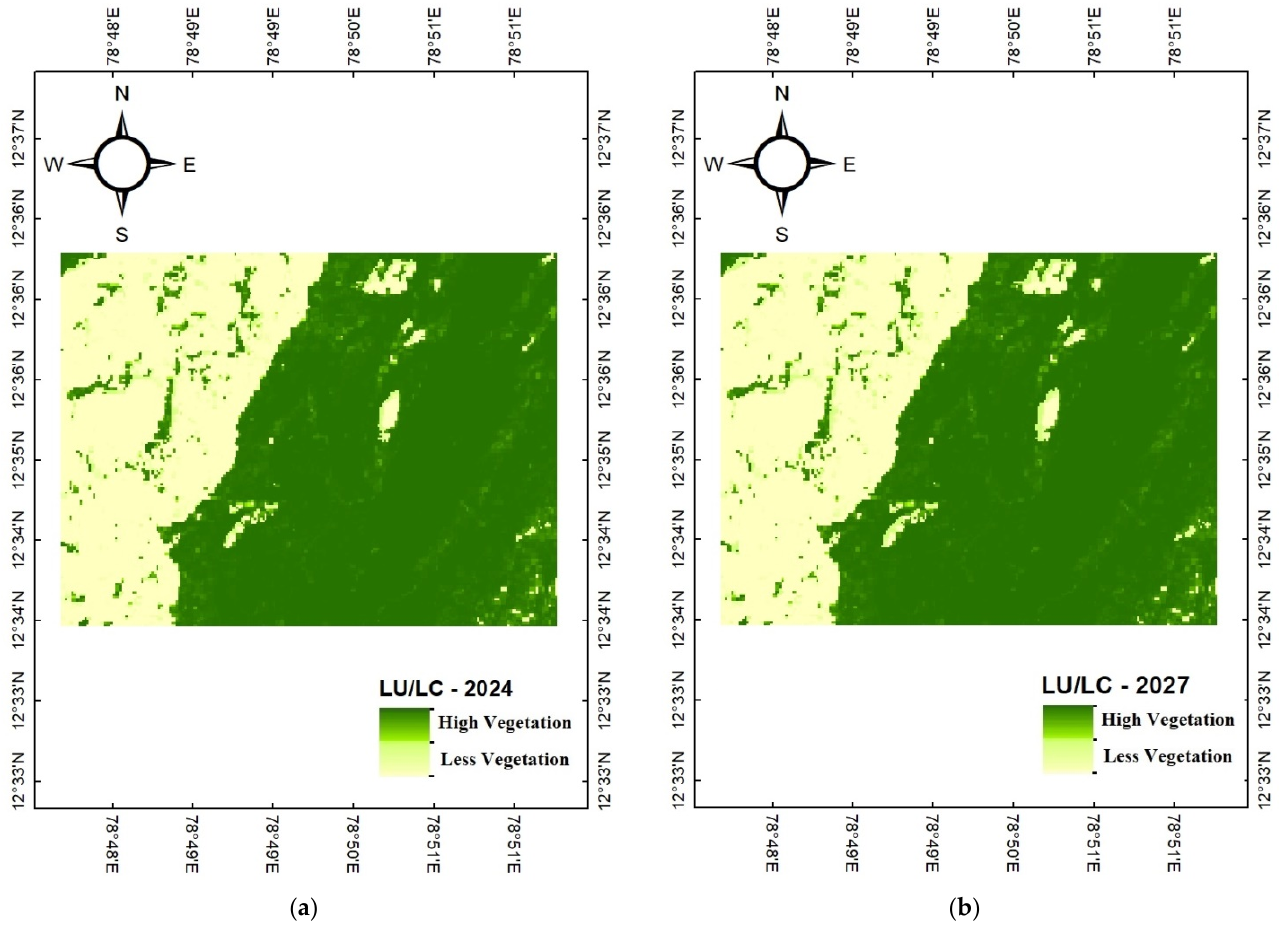
Figure 14. LU/LC prediction map of Javadi Hills for the years ( a ) 2024 and ( b ) 2027.